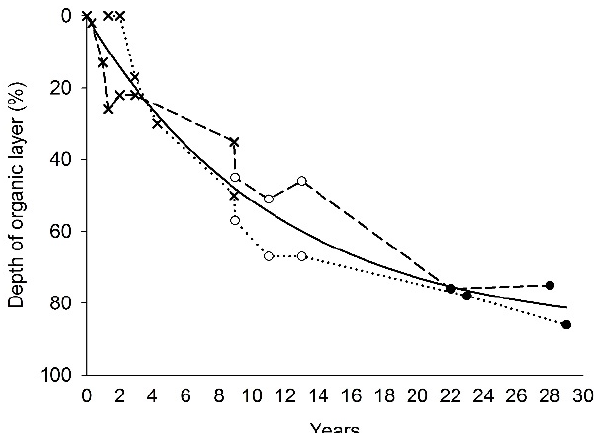
Figure 10. Vertical transport of needles, cones and strips in the moss habitat (dotted line) and the needle mat habitat (stippled line) over time. Crosses are needles, open circles represent underside of cones and filled circles are nylon strips. The degree of vertical transport is shown by how many % of the organic layer (Oi + Oe + Oa) that had been passed. Hundred % would indicate that the spodic horizon had been reached. The adapted, dark curve indicates a gradual reduction in the rate of vertical transport with time. From [16].